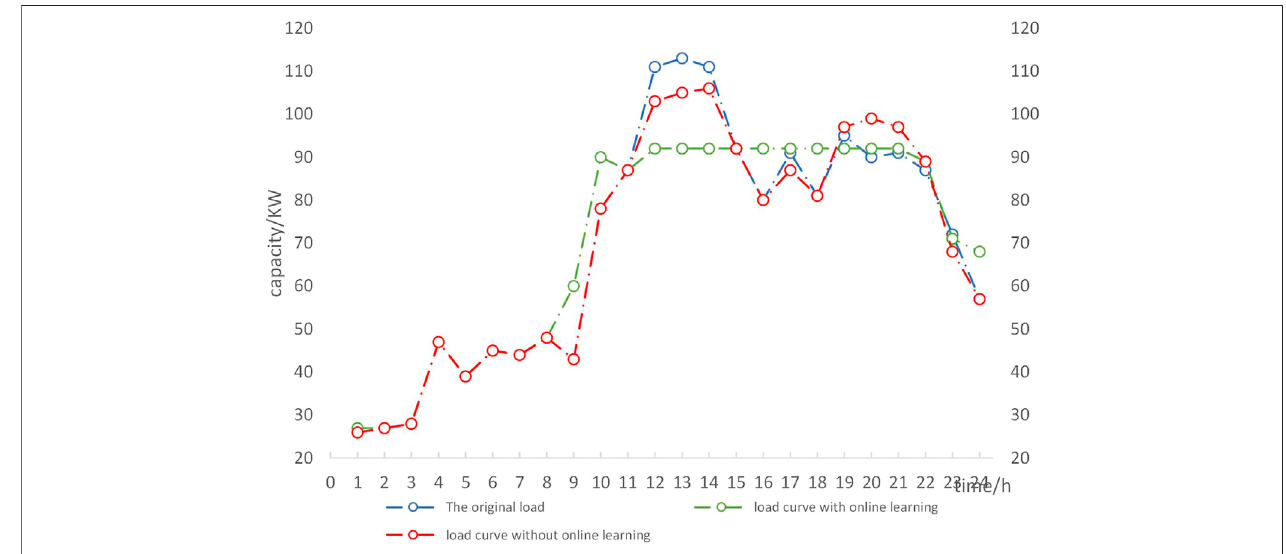
FIGURE 3 | Load contrast